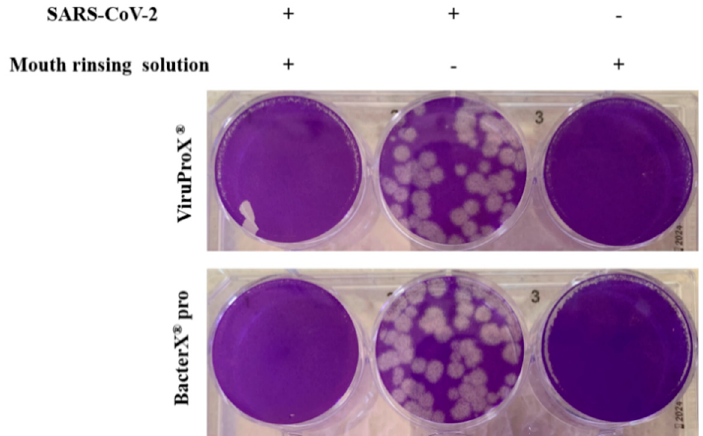
Figure 1. Reduced infectivity of SARS-CoV-2 after incubation with mouth rinsing solutions. SARS- CoV-2 (1 × 10 6 pfu) was incubated for 30 s with two mouth rinsing solutions ViruProX ® and BacterX ® pro (left well) and tested for infectious viral particles in a standard plaque assay on Vero E6 cells, compared to a medium control (center well) and a no-virus control (right well). Each solution was tested in duplicates in two independent experiments. ViruProX ® and BacterX ® pro lead to a complete reduction of infectious viral particles.